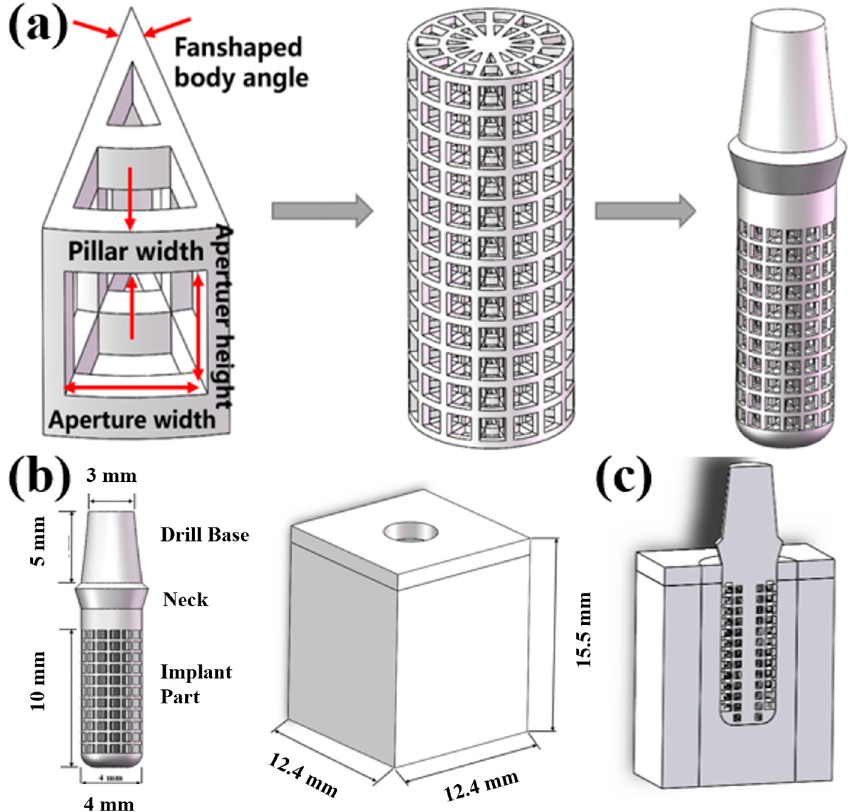
Figure 10. Three-dimensional model of implant and mandible: ( a ) Implant model creation process. ( b ) Implant and mandible model size parameters. ( c ) Sectional view of implant-mandible mode.